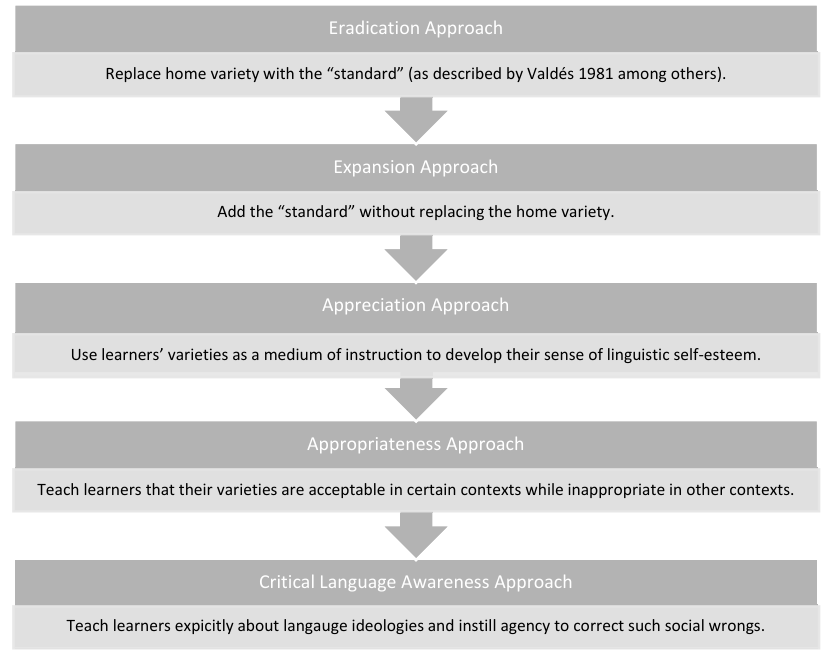
Figure 1. Approaches to SHL non-prestigious varieties (based on Beaudrie 2015).